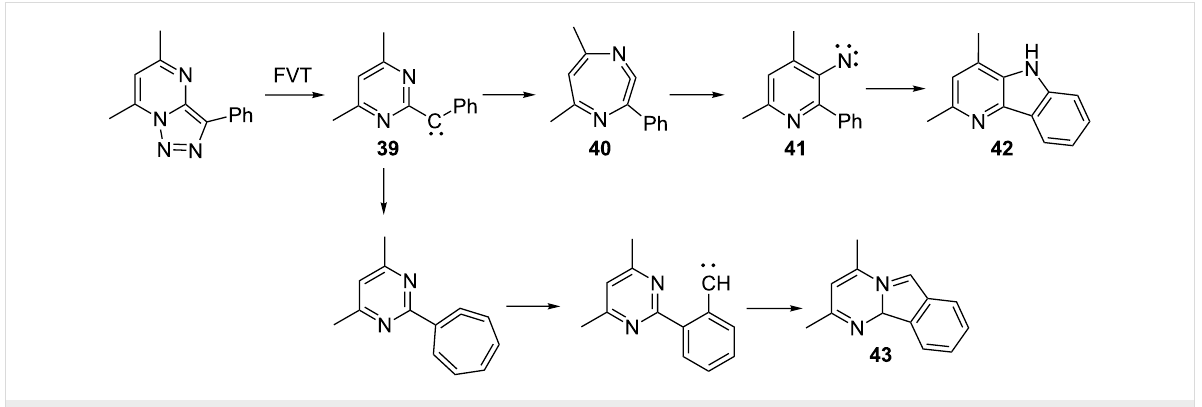
Scheme 10: Rearrangements of